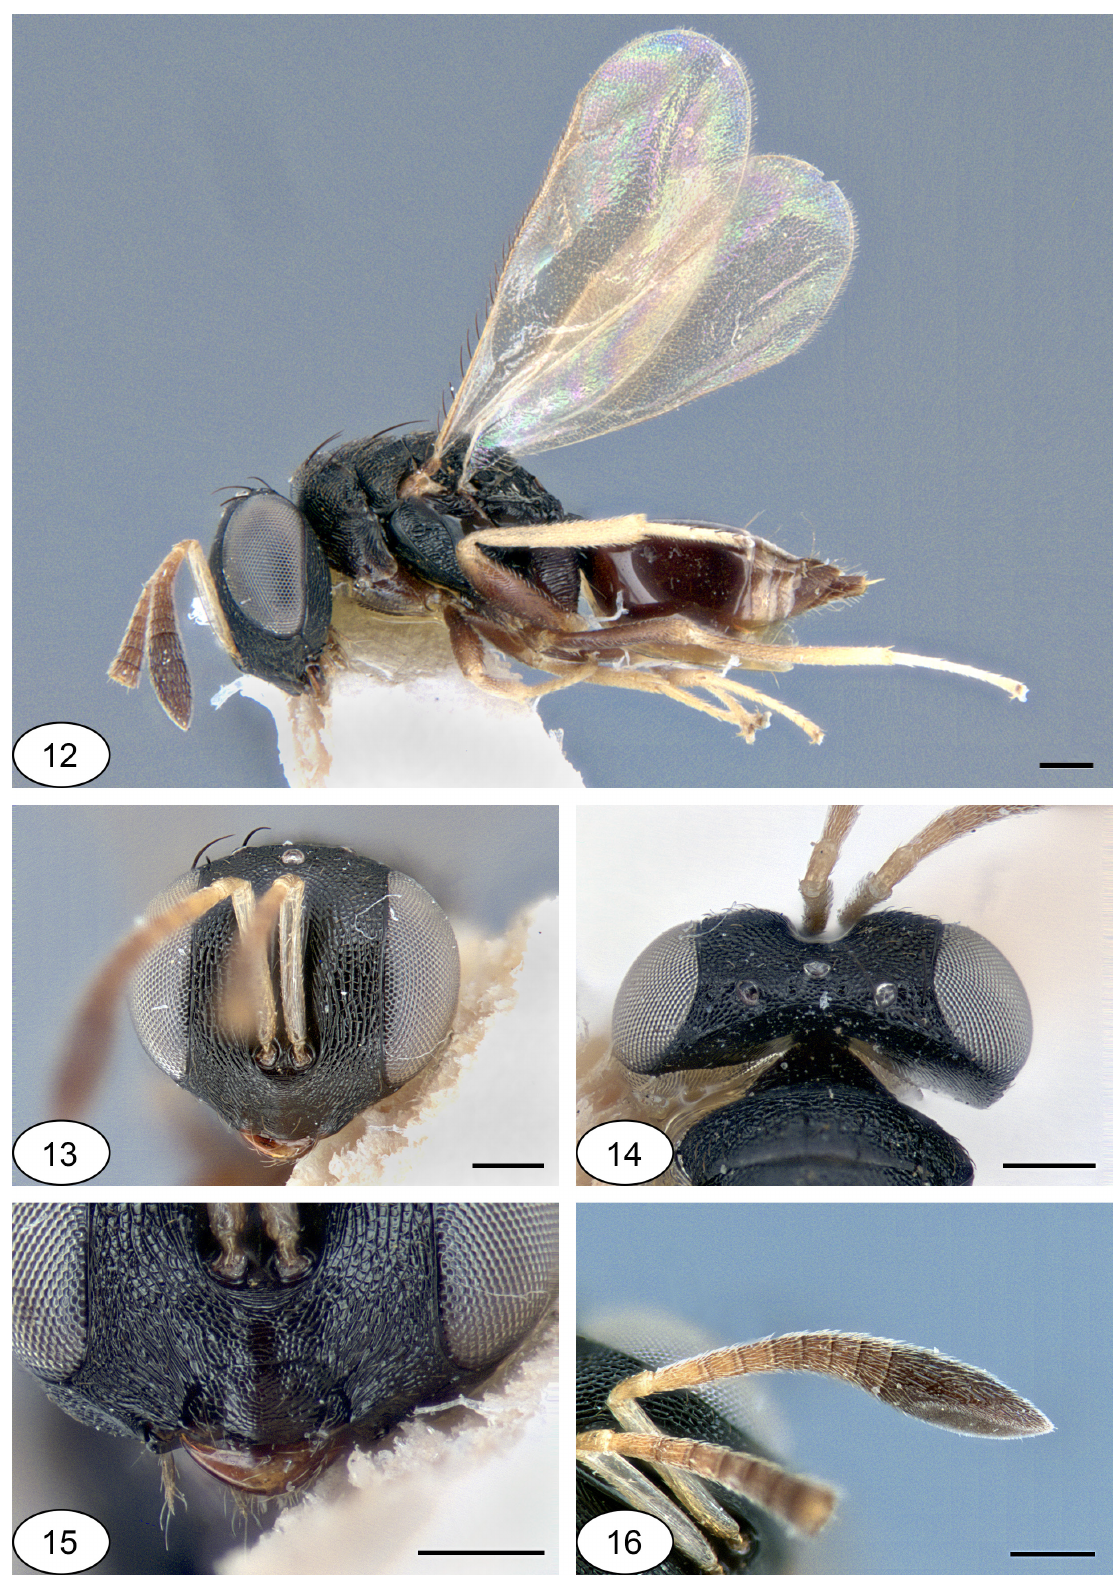
Figs 12–16. Netomocera alboscapus Hedqvist, 1971, holotype, ♀. 12 . Habitus, lateral view. 13 . Head, frontal view. 14 . Head, dorsal view. 15 . Lower face. 16 . Antenna. Scale bars: 0.2